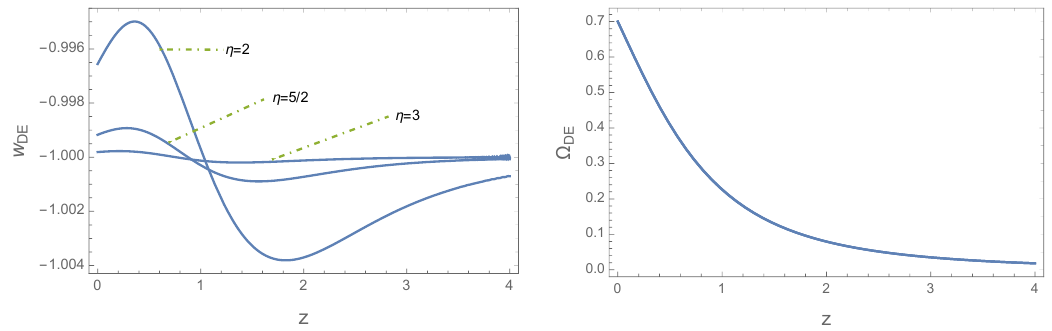
Figure 1 . The evolution of w DE and Ω DE for the (3.5), assuming Ω m 0 = 0 . 3 . For all cases α = 2 . The initial redshift is z i = 10 for η = 2 , z i = 8 for η = 5 / 2 and z i = 6 . 39 for η = 3 . In all cases the evolution of Ω DE is indistinguishable from that of Λ